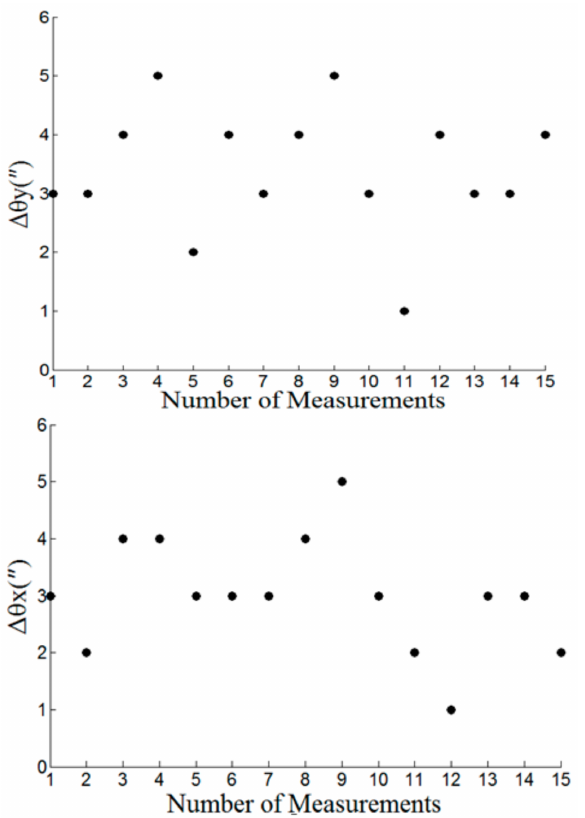
Figure 14. Alignment error testing results for four-axes calibration table. Experimental results show that installation error of two-axes translation within the angle compensation range of theodolite, four-axes calibration table has an alignment accuracy of 5 arc sec for both horizontal and vertical angle, which is able to calibrate any detector of multidetector mosaic imaging systems